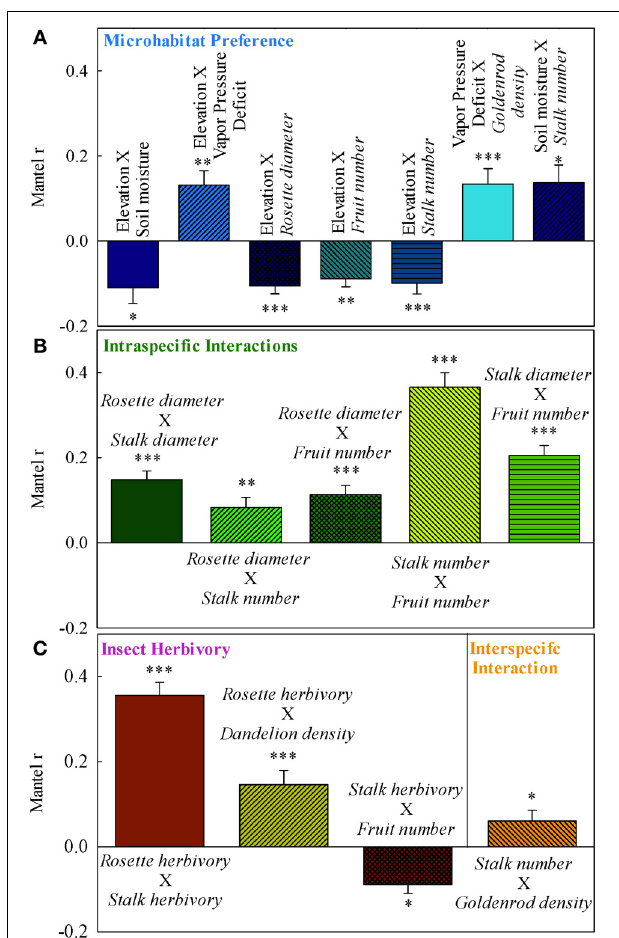
FIGURE 3 | Simple Mantel correlations for (A) environmental controls, (B) intra-specific interactions, and (C) inter-specific interactions. Error bars mark the 90% confidence interval for correlation coefficients. ∗∗∗ P ≤ 0 . 001; ∗∗ 0.001 < P ≤ 0 . 01; ∗ 0.01 < P ≤ 0 . 05. Only significant ( P ≤ 0 . 05) interactions are